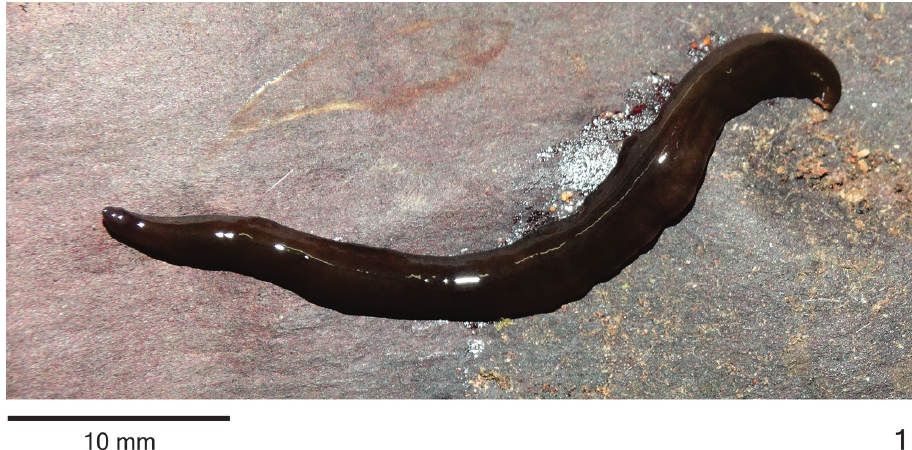
Figure 1. Cratera cryptolineata sp. n., holotype, habitus, dorsal apparatus: sagittal sections on 20 slides. MZU PL.00219: leg . J. A. L. Braccini, 2 June